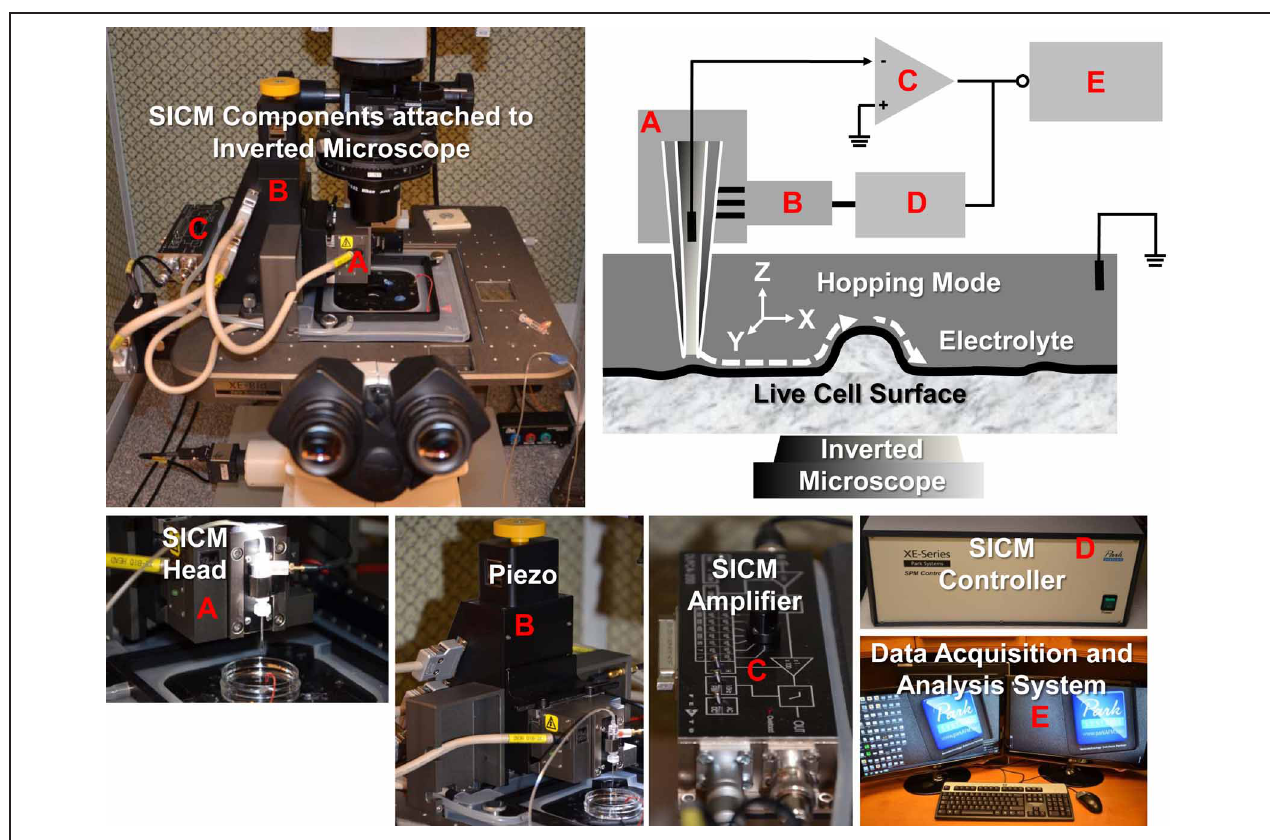
FIGURE 1 | SICM components and schematic diagram of SICM topography imaging of live cells with hopping mode. The XE-Bio SICM setup (Park Systems Corporation) consists of SICM head (A) , piezo (B) , SICM